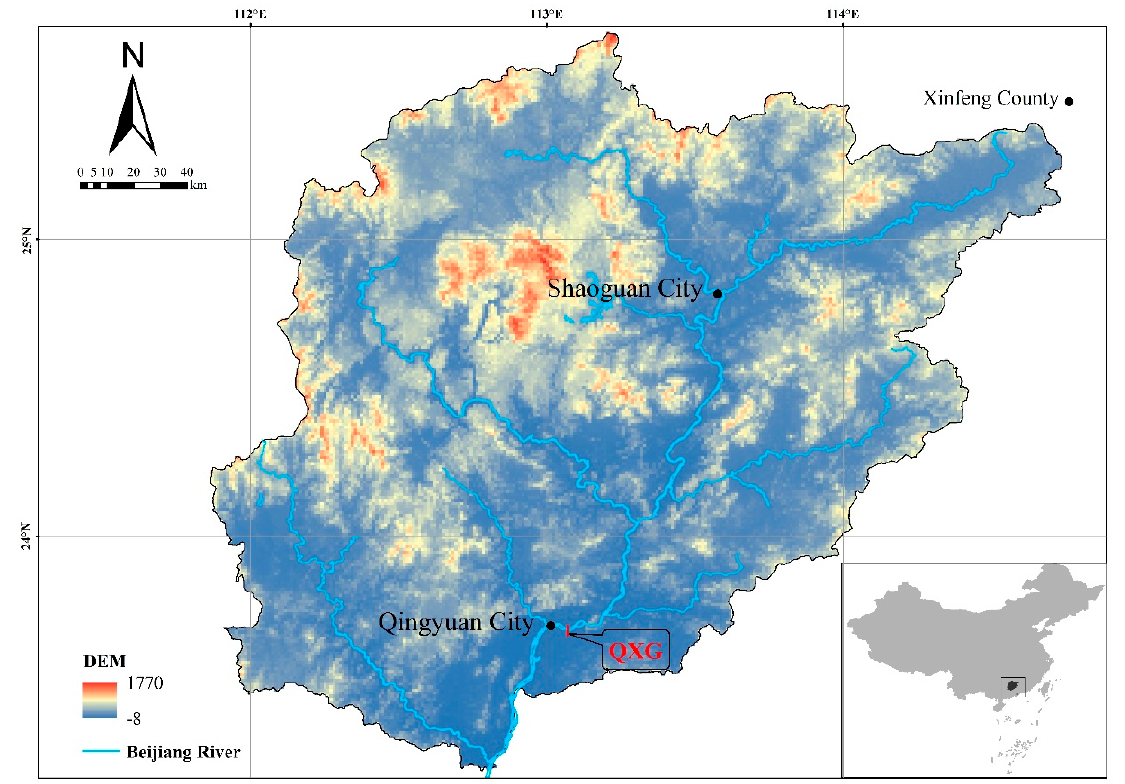
Figure 1. Location map of the monitoring section in the study area.